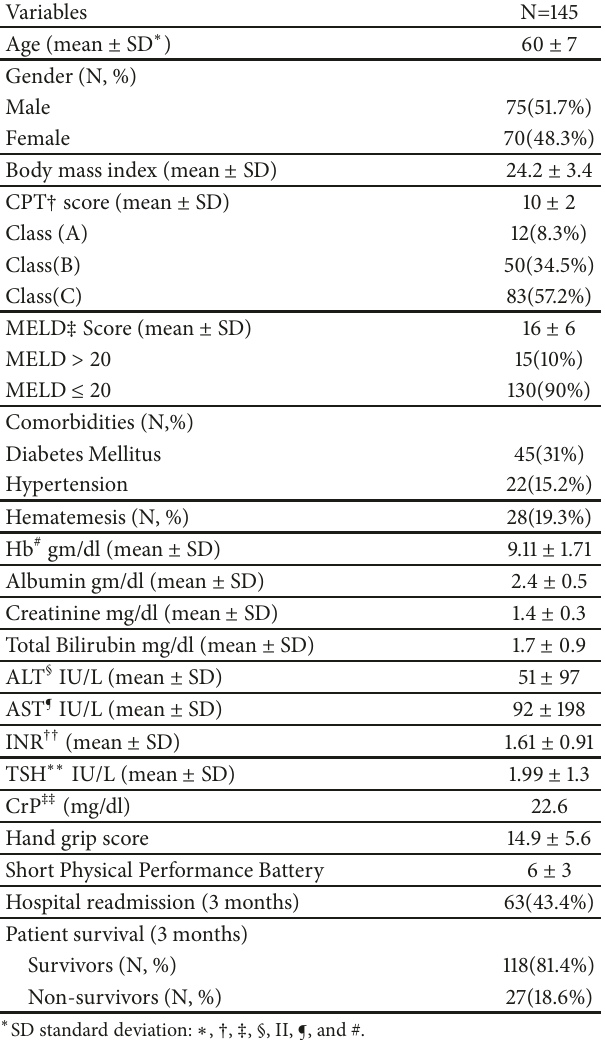
Table 1: Demographic, clinical, and laboratory data of the studied population.